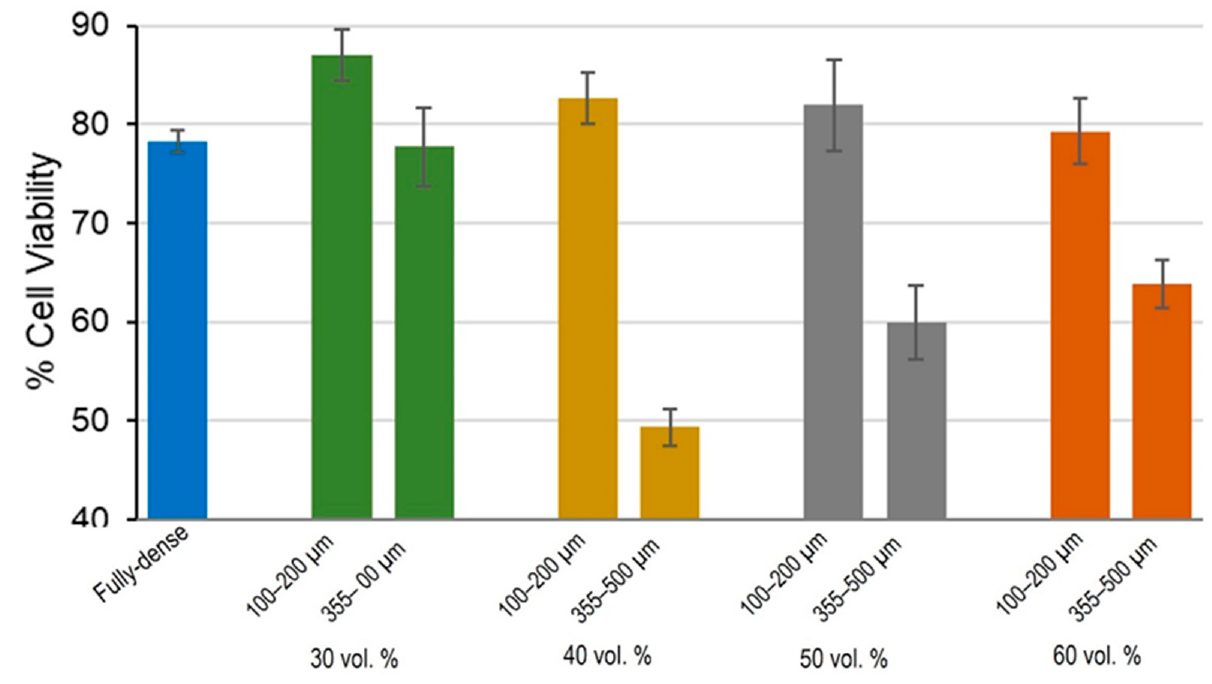
Figure 10. Effects of the percentage of porosity and pores range size on cell viability in MC3T3–E1 cells. Results are represented as % cell viability.